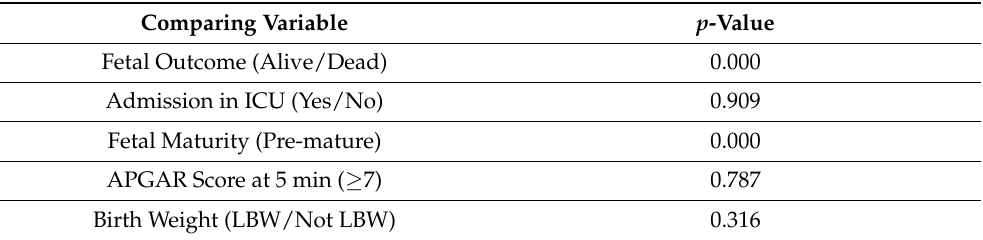
(application of Chi-Square test keeping the level of significance ≤